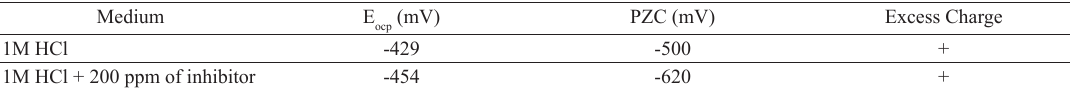
SO solutions in the presence and absence of inhibitor. 2 4